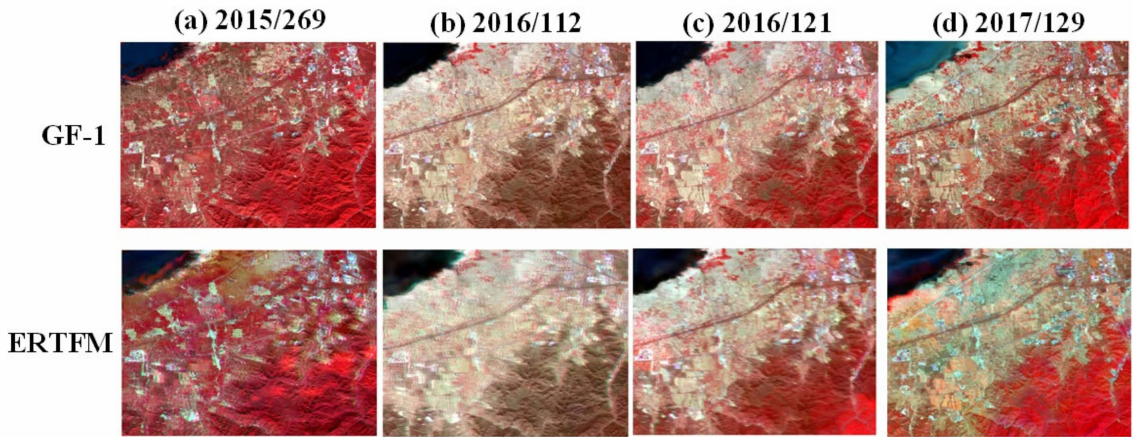
Figure 3. The actual GF-1 images (RGB composite) and the predictions by the